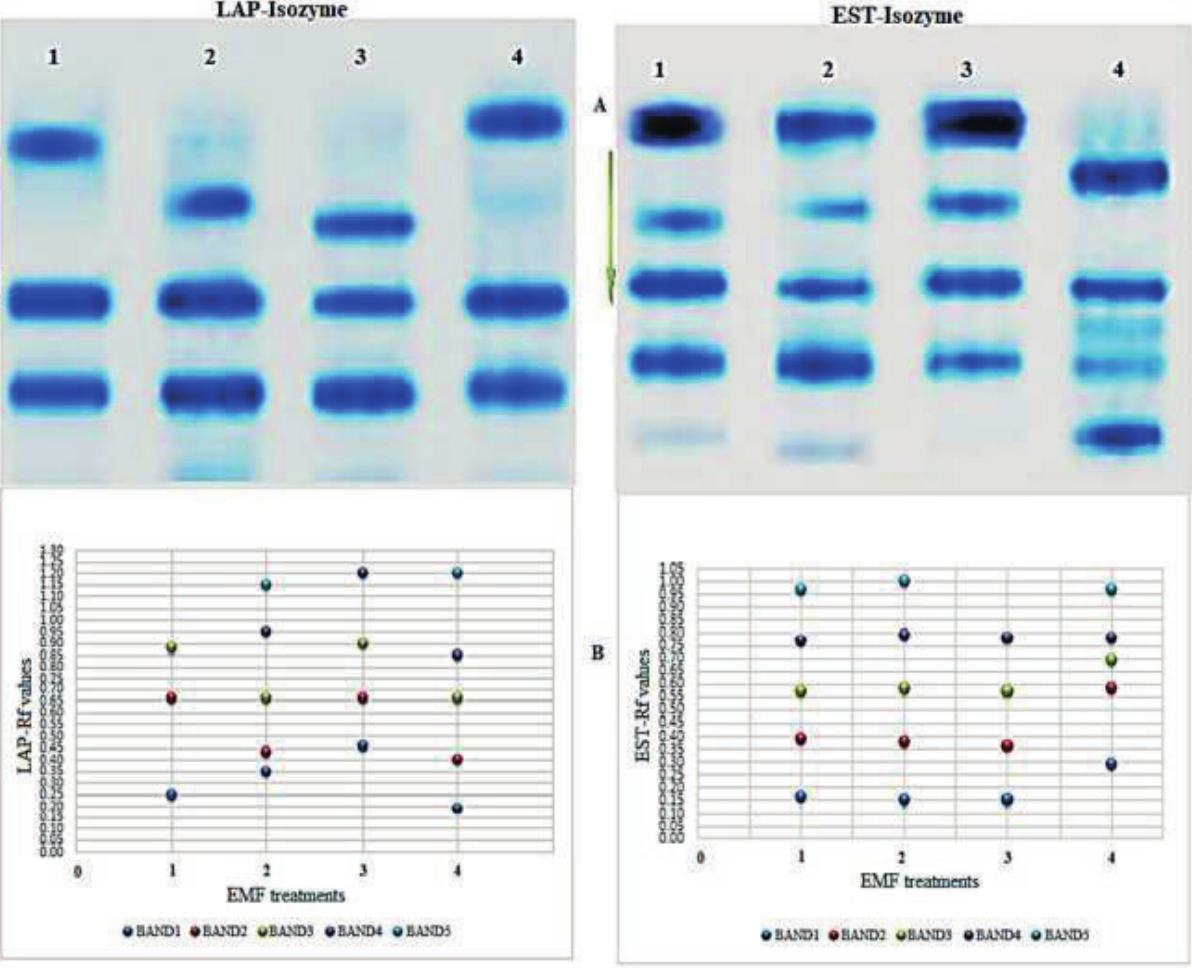
Figure 2. (A) Isozymatic patterns and (B) schematic distribution of Leucine-aminopeptidase (LAP) and Esterase (EST) zymograms (R f val- ues) of non-exposed and EMR exposed seedlings of Zea mays for days of exposure times (Ex-0, Ex-1, Ex-3, and Ex-5) based on relative front (R f ) Values and optical densities (OD). Lanes 1–4 represented the days of exposure times (Ex-0, Ex- 1, Ex-3, and Ex-5),